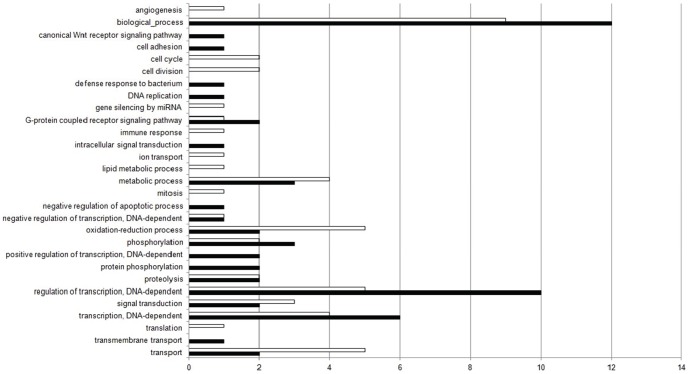
Comparison of Top20 GO terms found in the Biological Process category.Percentage of Top20 terms related to the down-regulated (black bars) and up-regulated genes (white bars), selected in the Biological Process category.